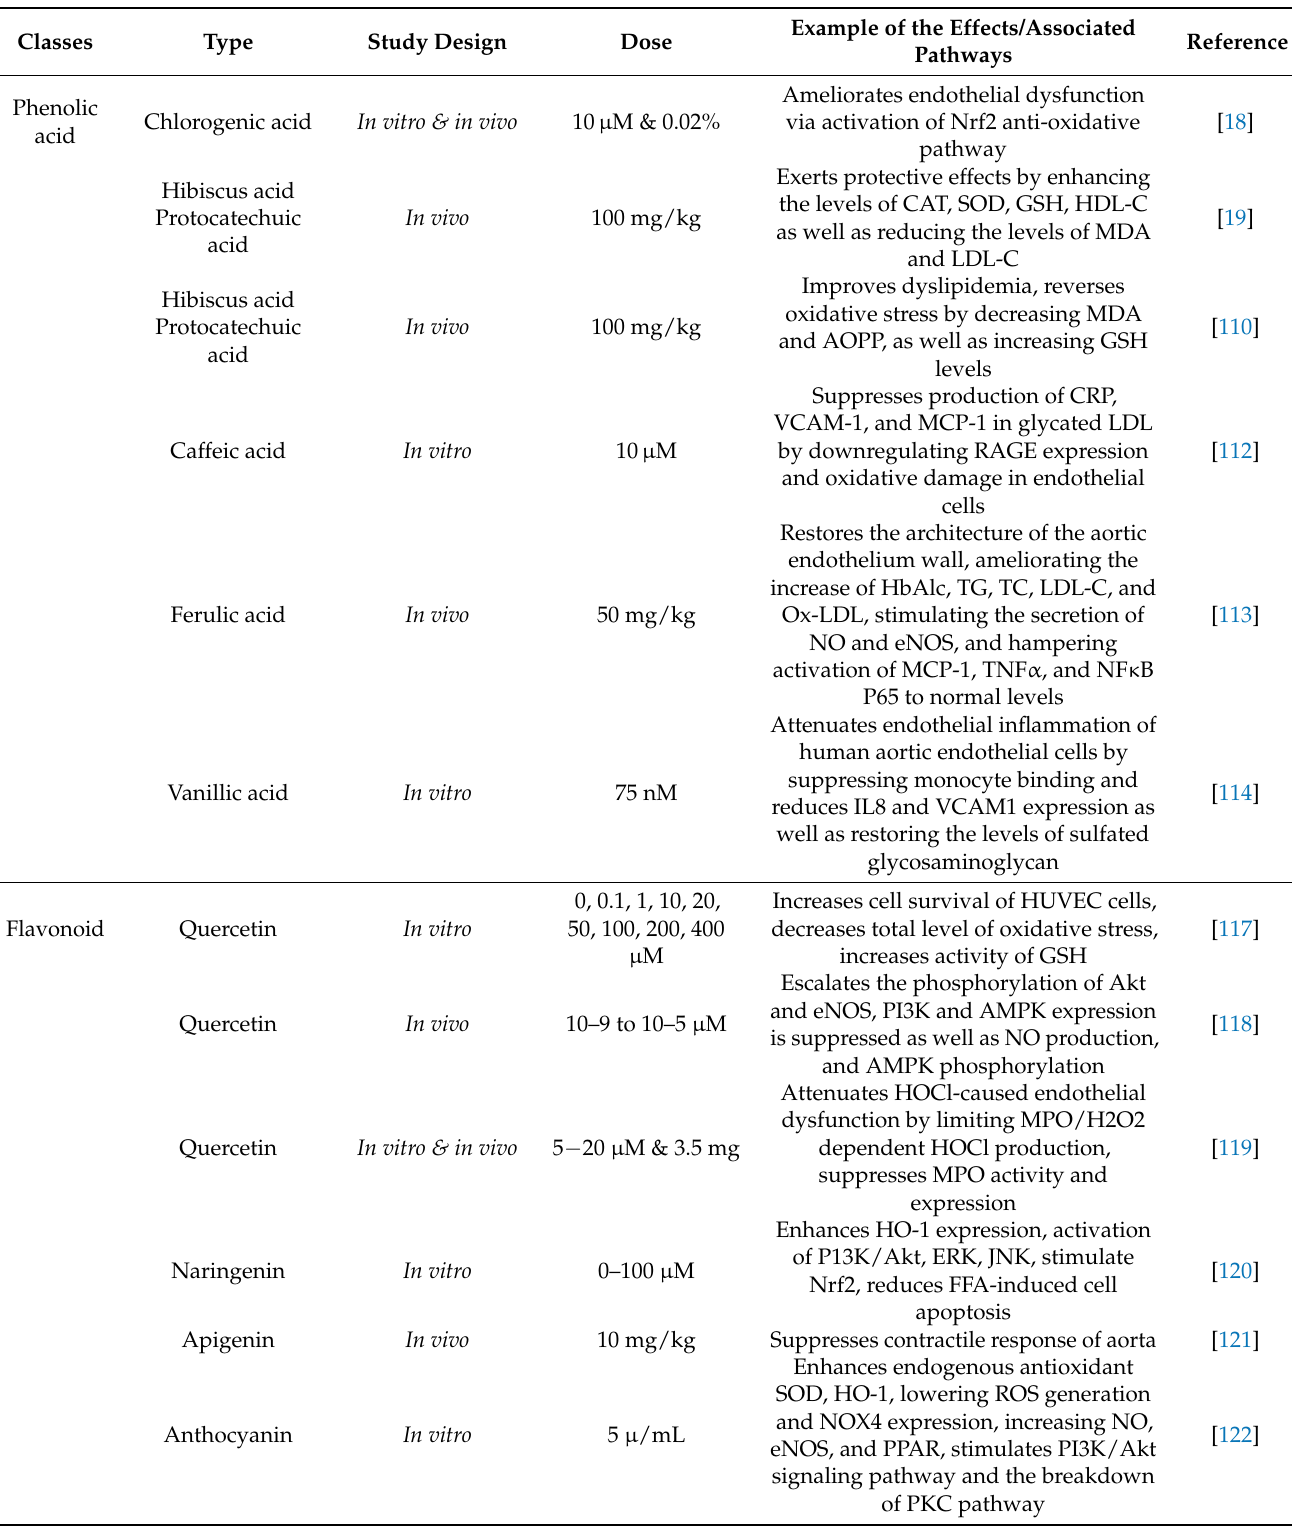
Table 1. Summary of the protective effect of polyphenols in ameliorating diabetes-induced vascular